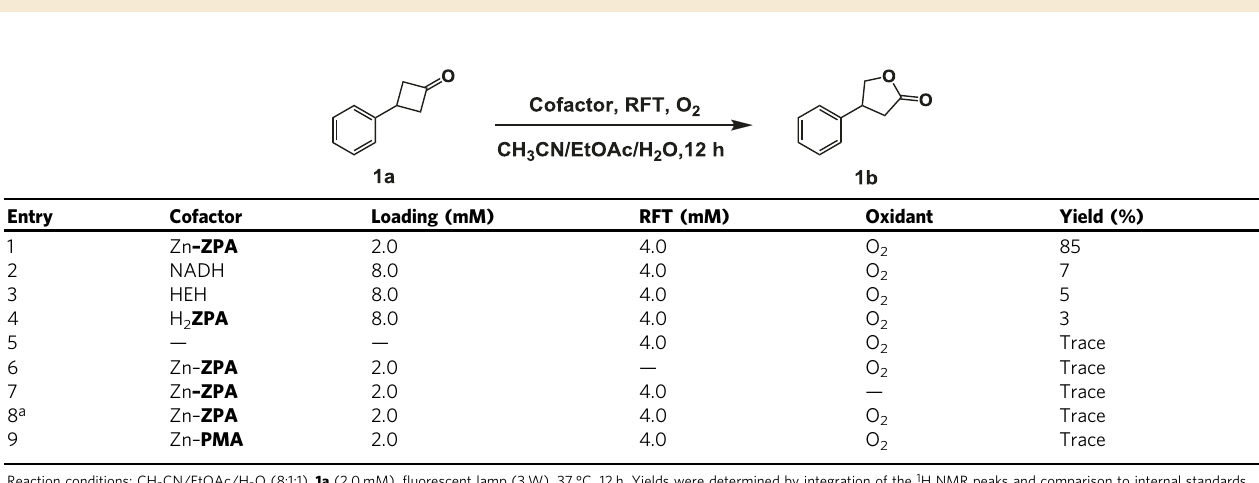
Table 1 The Baeyer – Villiger oxidation of 3-phenylcyclobutanone catalyzed by RFT with different cofactors in the presence of oxygen.